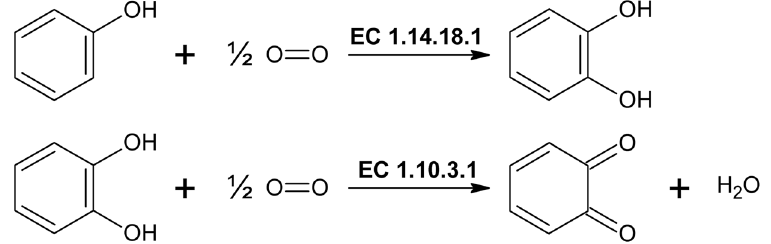
Figure 1. Tyrosinase catalyzes the o -hydroxylation of monophenols (top) and the oxidation of o -diphenols (bottom).